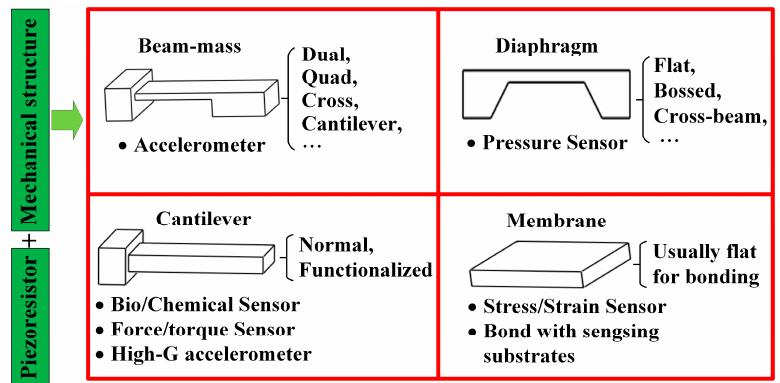
Figure 1. Classic structures for piezoresistive sensors.